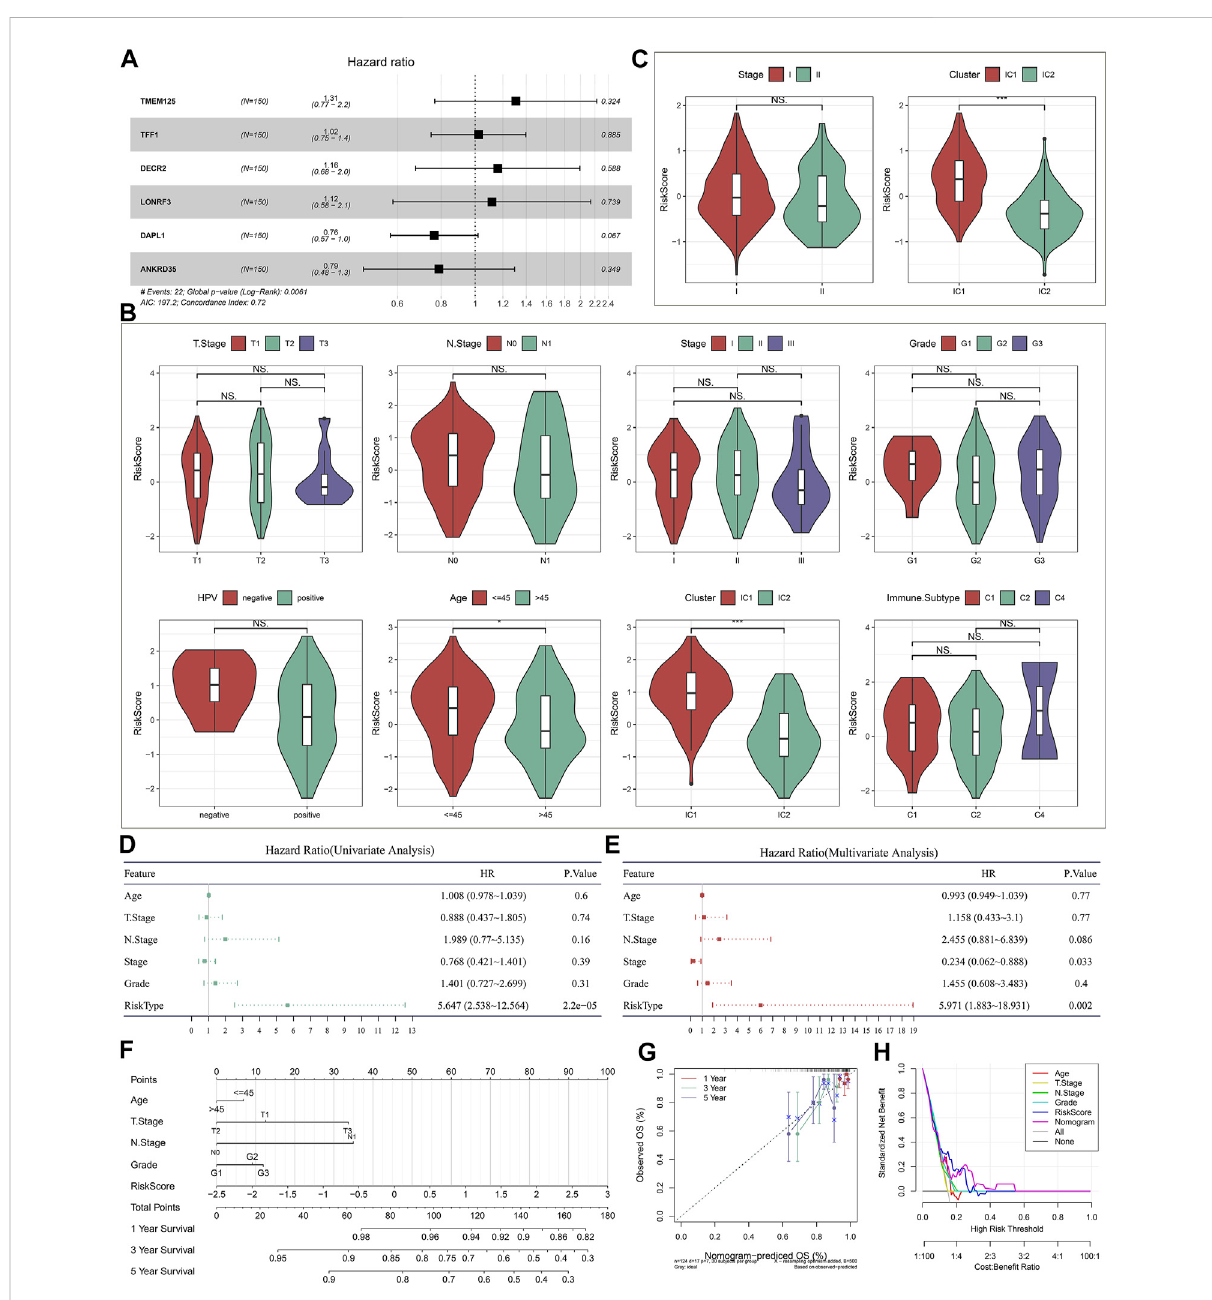
FIGURE 9 Evaluationoftheclinicalsigni fi canceoftheimmunesubtype-relevantrecurrencemodelandestablishmentofanomogramforcervicalcancer. (A) Forest diagram of multivariate cox regression analysis of each variable in the recurrence model in the TCGA dataset. (B) Distribution of the risk score acrossdistinctclinicopathologicalparametersintheTCGAdataset. (C) Distributionoftheriskscoreacrossdistinctclinicopathologicalparametersinthe GSE44001dataset. (D,E) Uni-andmultivariatecoxregressionanalysisfortheassociationsoftheriskscoreandclinicopathologicalparameterswith DFSintheTCGAdataset. (F) EstablishmentofanomogramincludingindependentvariablesintheTCGA dataset. (G) Calibrationcurvesforassessingthe nomogram-predicted and actual survival outcome. (H) Decision curve analysis for evaluation of the net bene fi